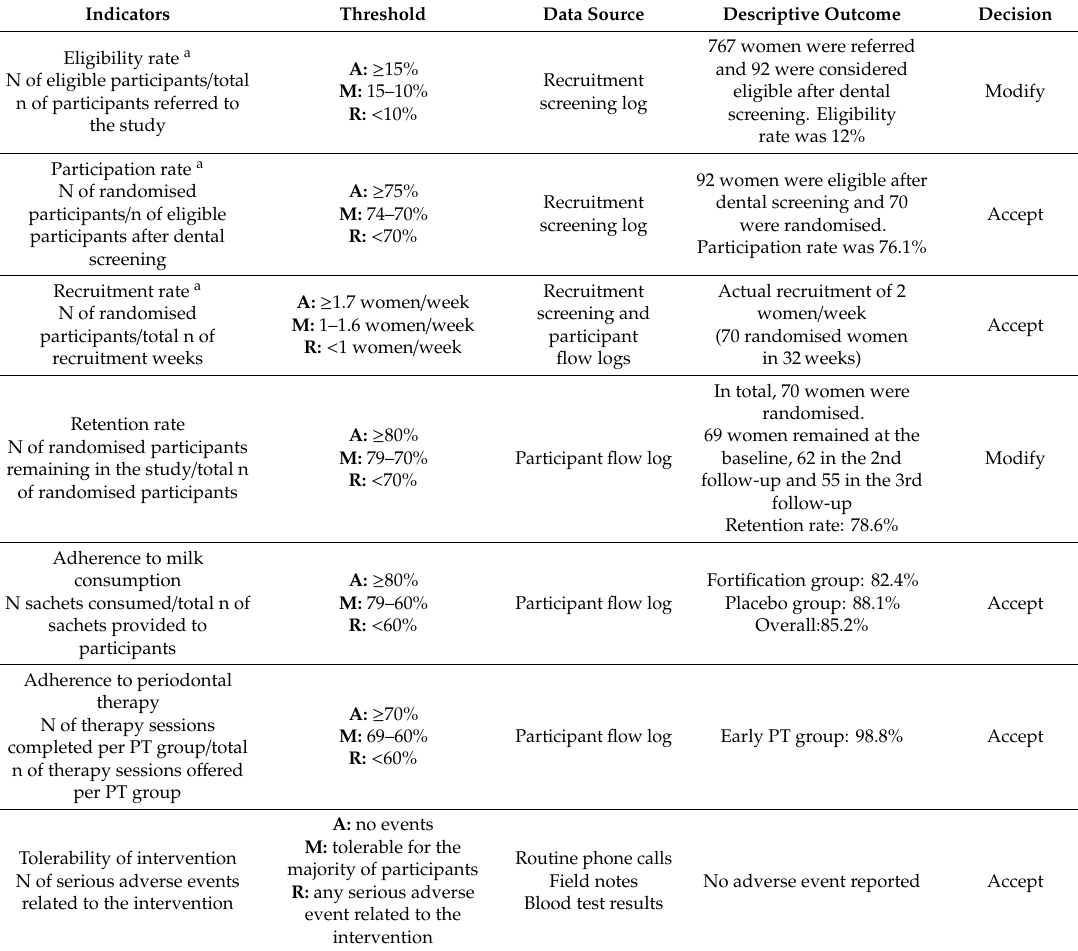
Table 1. Adapted checklist for feasibility, acceptability, tolerability, and adherence of trial design, study procedures and intervention. Threshold Data Source Descriptive Outcome